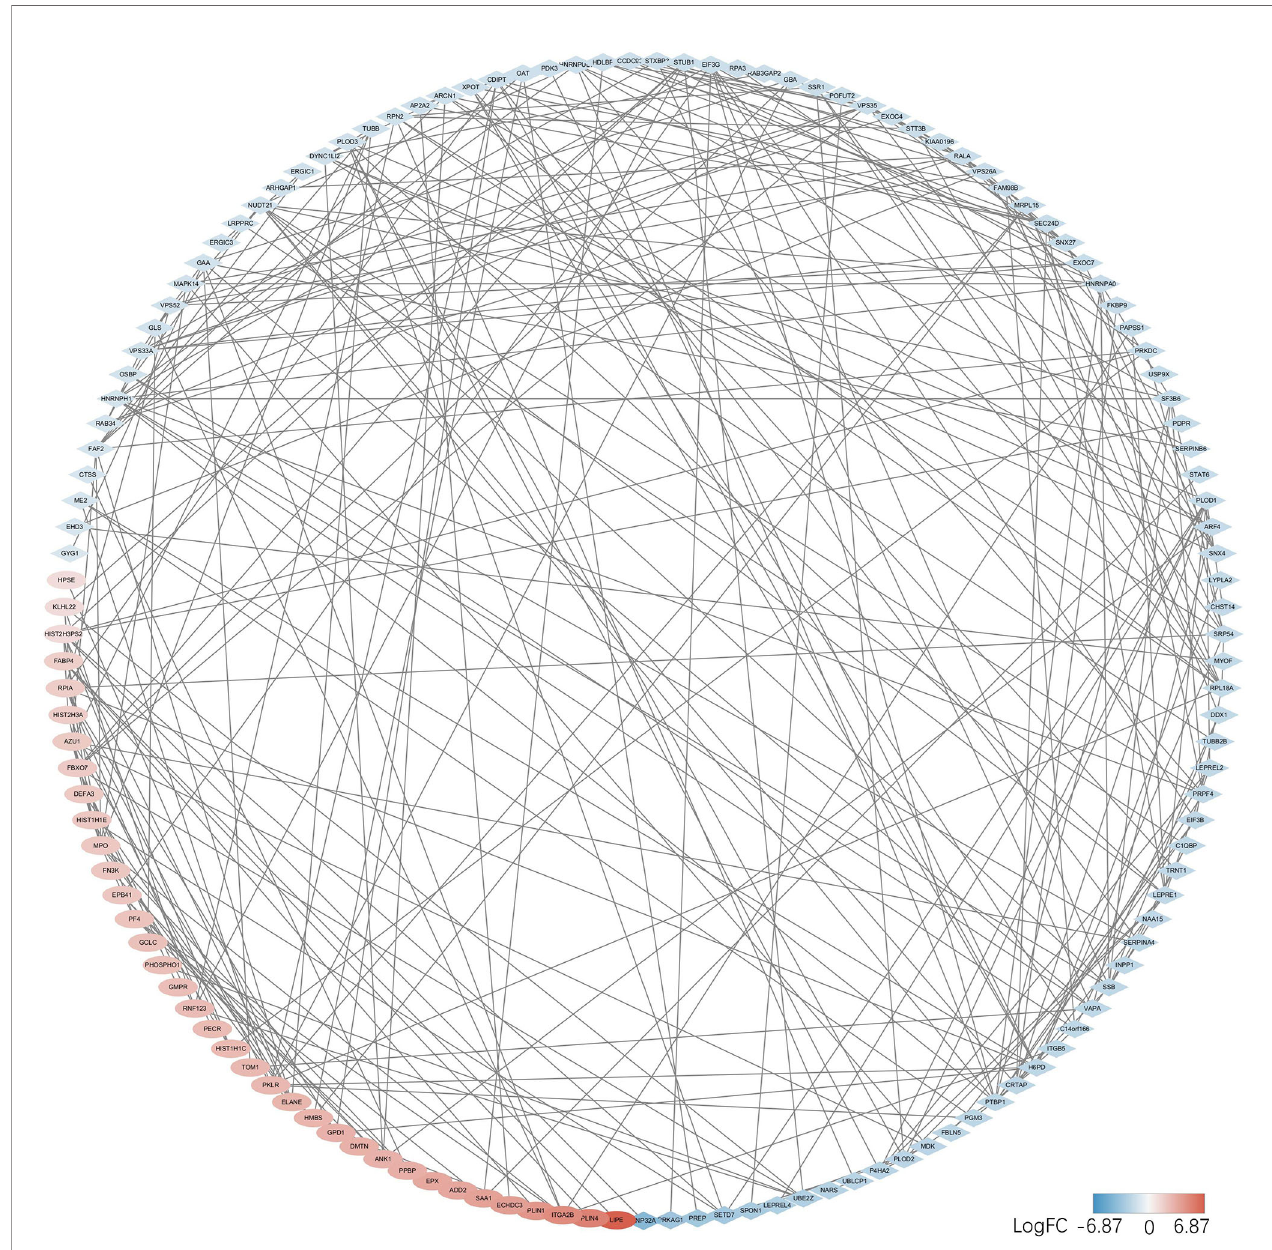
FIGURE 6 | DEPs in the PPI networks are visualized by the Cytoscape. Red balls represent the upregulated proteins, and the blue diamonds represent the downregulated